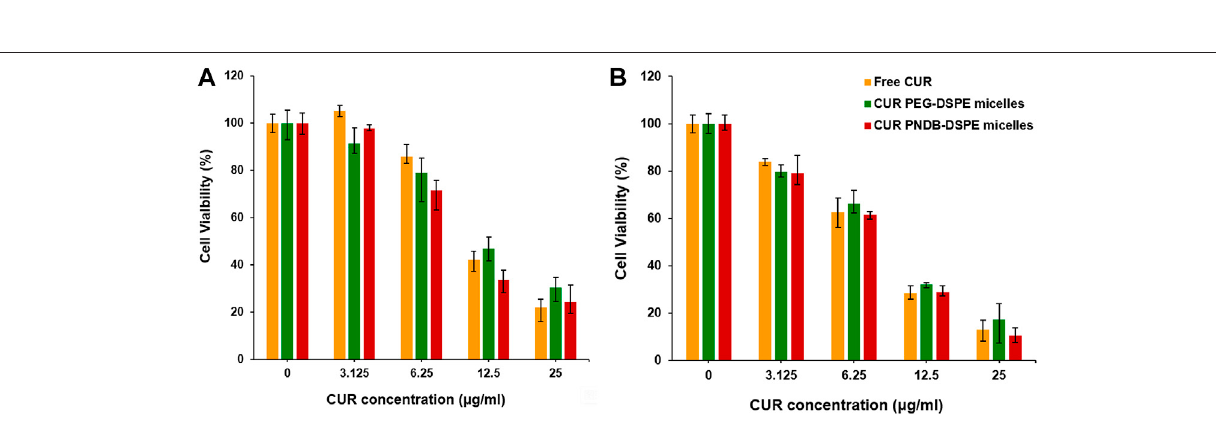
Frontiers in Bioengineering and Biotechnology |